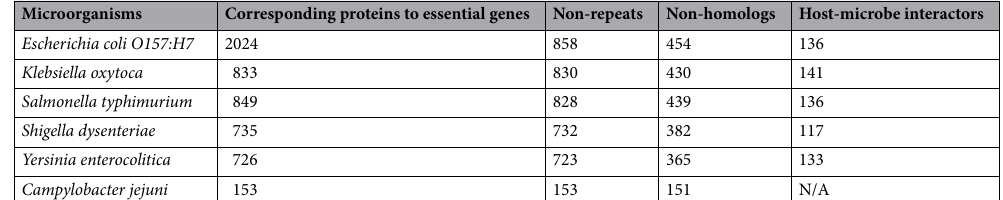
Table 2. Filtering and host-microbe interactions of protein sequences corresponding to essential genes of target microorganisms.